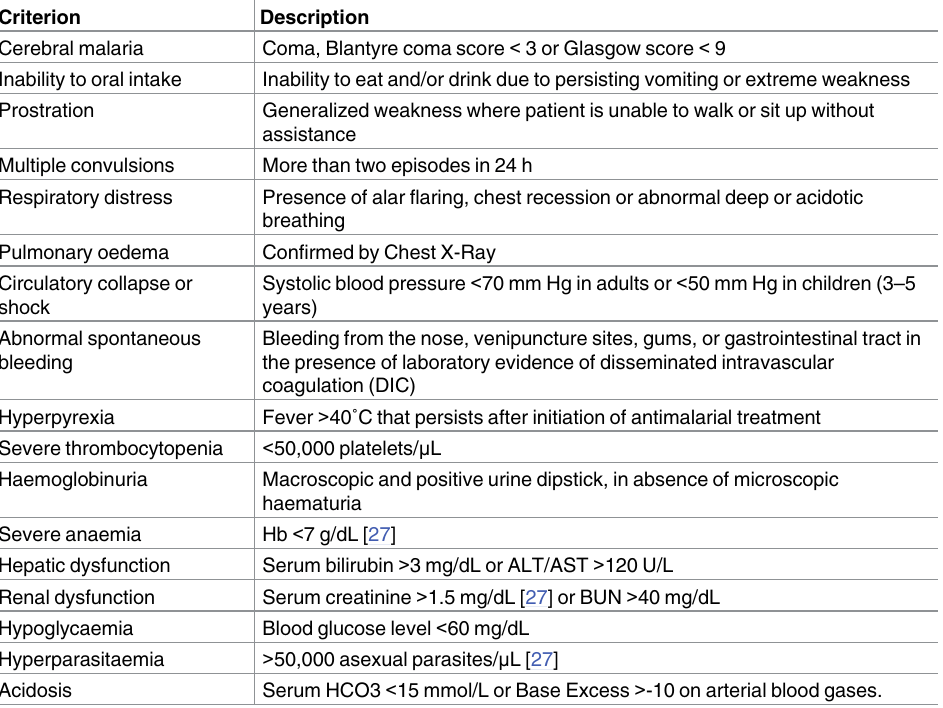
Table 1. Severemalaria criteria according to WHO [26] and the Colombian MoH guidelines [27].